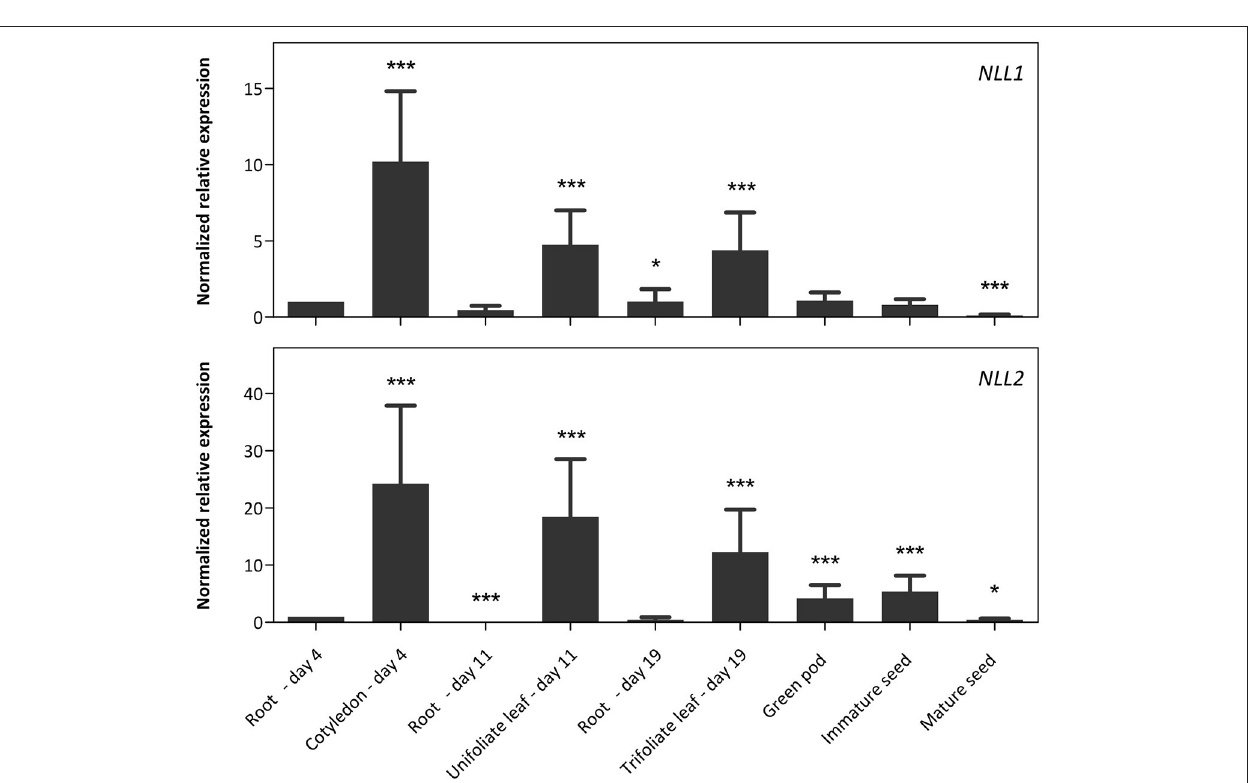
FIGURE 3 | Normalized relative expression profile of the three GmNLL genes during the development of the soybean plant. The normalized transcript levels of all genes are represented relative to the expression of 4-day-old roots. The data represent three independent biological replicates, error bars indicate standard errors and statistically significant differences to the expression level of 4-day old roots are indicated with asterisks (* p < 0.05, *** p < 0.001).